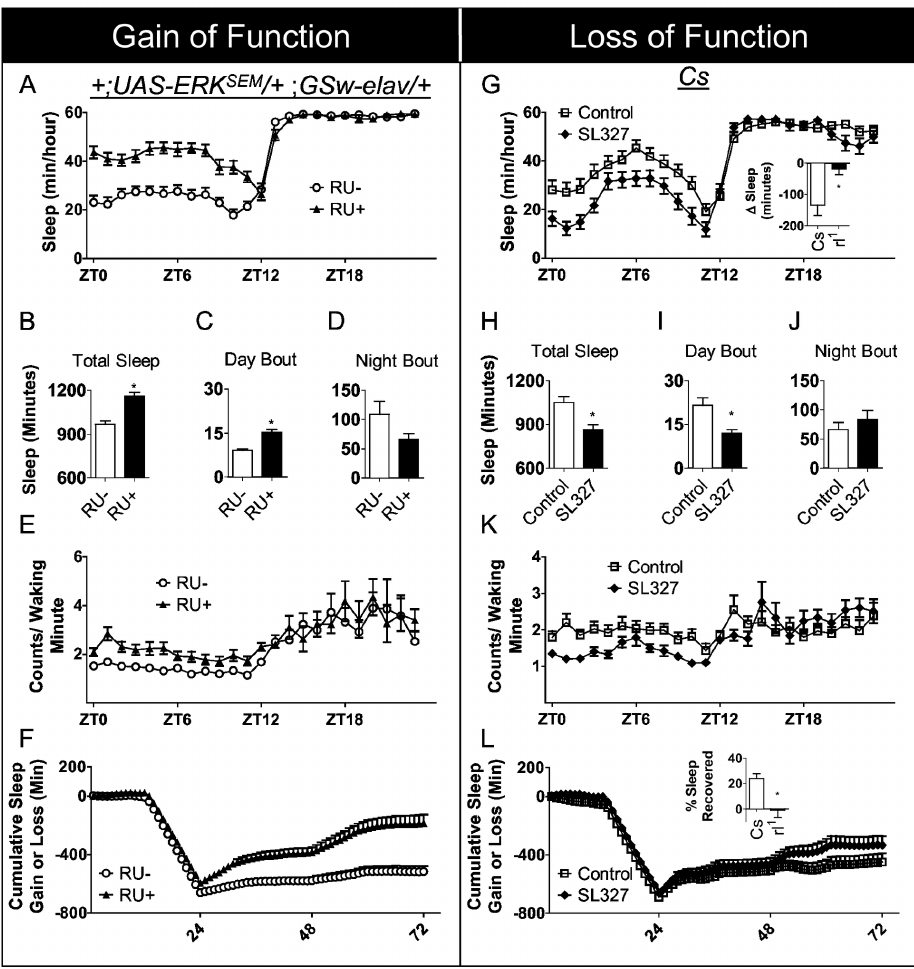
Figure 1. ERK activation increases sleep. A , Pan-neuronal expression of activated ERK in adult flies results in an increase in sleep. Sleep is shown in minutes/hour in RU486 (RU+) fed + ; UAS-ERK SEM /+ ; GSw-elav/+ flies and their vehicle fed controls (RU-). A 2(RU+, RU-) X 24(Hour) ANOVA reveals a significant drug by hour interaction F = 7.42, P = 5.1E-23,(n = 32/ group). B - D , (23,1488) Total sleep time and sleep bout duration during the light period were significantly increased in RU+ fed + ; UAS-ERK SEM /+ ; GSw- elav/+ compared to RU- controls, p = 7.25E-7 and p = 1.77E-6, respectively; student’s t-test, n=31-32/group. RU+ treated flies showed no change in sleep consolidation at night p = 0.103; student’s t-test, n=31-32/group. Data are presented as mean ± SEM, (* = p < 0.05). E , RU fed + ; UAS-ERK SEM /+ ; GSw-elav/+ showed increased activity during waking (ZT1-ZT12) compared to vehicle fed controls; A 2(RU+, RU-) X 12(Hour) ANOVA reveals a significant main effect of drug F = 88.47, P = 1.08 E-19] (n = 26/ group). (1,600) F , RU+ fed + ; UAS-ERK SEM /+ ; GSw-elav/+ showed an exaggerated homeostatic response following 12 h of sleep deprivation compared to RU- fed siblings. Data are presented as cumulative loss then gained in minutes. A negative slope indicates sleep lost, and a positive slope indicates sleep gained; when the slope is zero, recovery is complete. A 2(RU+, RU-) X 72(Hour) ANOVA reveals a significant drug by hour interaction [F = 8.08, P = 2.88E-73] (n = 28/ group). G , Pharmacological inhibition of ERK in (71,3888) adult Cs flies reduces sleep. Adult flies were fed 2mM of the Mitogen-activated protein kinase kinase (MEK) inhibitor SL327. Two- way ANOVA reveals a significant interaction of drug (SL3227, control) treatment by time [ F ( ) = 9.57, P = 2.4E-31] (n = 30 for 23,1392 each group). Inset shows that SL327 administration reduces total sleep time significantly in wild type Cs flies but did not alter total sleep in the Drosophila rl 1 mutants p= 0.08 (shown in inset), suggesting specificity of the drug to cause the sleep reduction phenotype. H - J , Total sleep time and sleep consolidation during the light period were significantly decreased in SL327 fed flies (n=30) compared to vehicle fed controls (n=30), p = 0.0008 and p = 0.0014, respectively; student’s t-test. SL327 did not alter sleep consolidation at night, p = 0.379, (* = p < 0.05). K , Activity during waking (ZT1-ZT12) is significantly reduced in adult Cs flies fed SL327 compared to vehicle fed controls; ; A 2(RU+, RU-) X 12(Hour) ANOVA reveals a significant main effect of drug [ F = (1,744) 57.74, P = 9.01E-14 (n = 32 flies)]. L , No change in sleep homeostasis was observed in SL327 fed Cs flies compared to vehicle fed controls; 2(SL327, control) X 72(Hour) ANOVA,[F = 0.393, P = 0.999 (n = 22/ group)]. (71,3024) doi: 10.1371/journal.pone.0081554.g001 PLOS ONE |